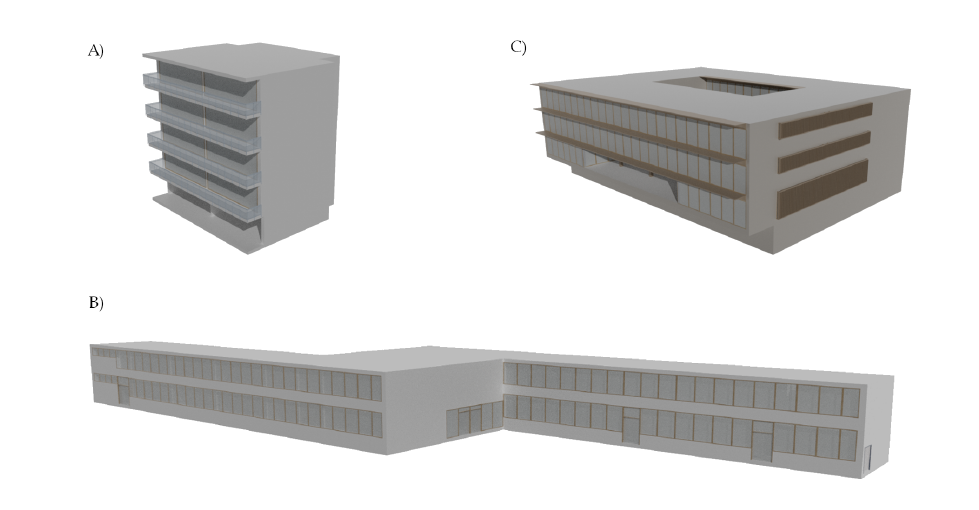
Figure 8. Analysed NZEB reference buildings: ( A ) Residential building (B1); ( B ) School (B2); ( C ) Office building (B3).